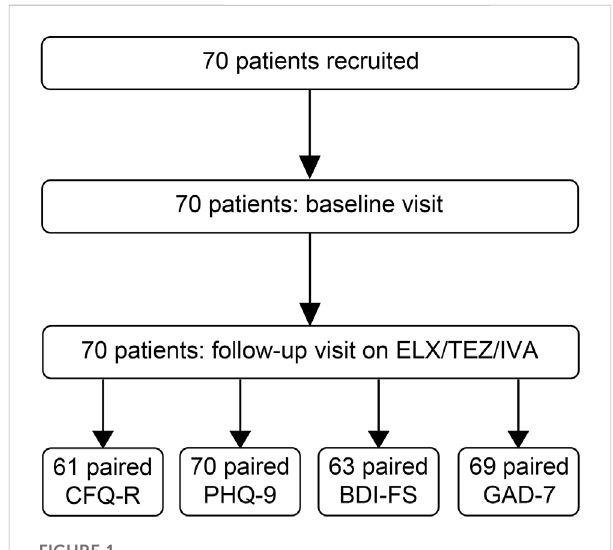
FIGURE 1 Flow chart of recruited patients with cystic fi brosis (CF) with at least one F508del mutation. BDI-FS = Beck ’ s Depression Inventory- FastScreen, CFQ-R = Cystic Fibrosis Questionnaire-Revised, ETI = elexacaftor/tezacaftor/ivacaftor, GAD-7 = Generalized Anxiety Disorder Scale-7 Items, PHQ-9 = Patient Health